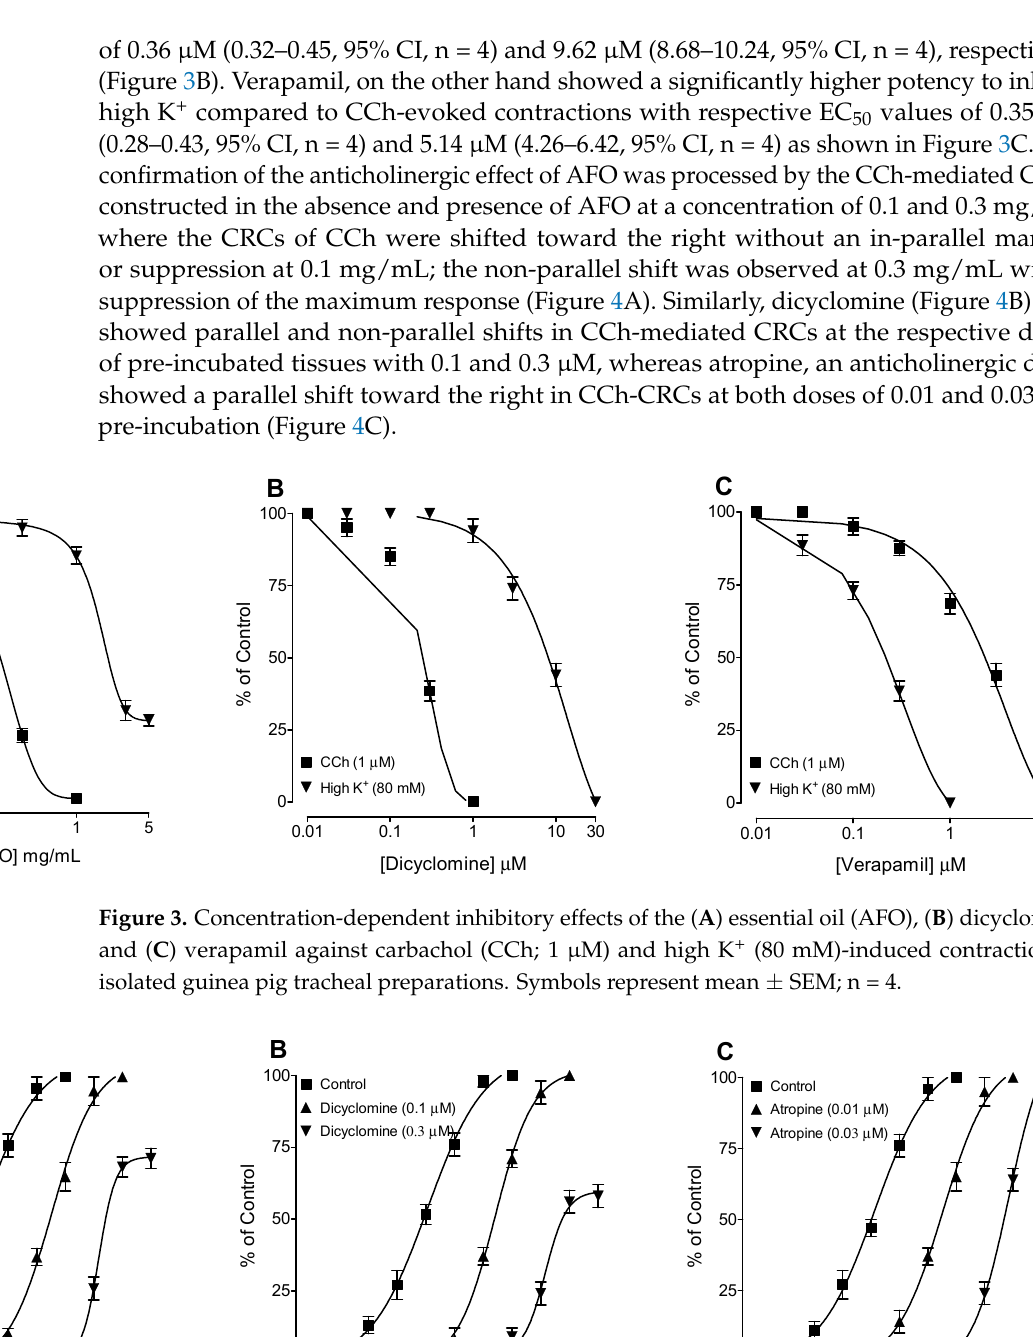
6 of 11 Figure 2. Chemical structure of some components of AFO.